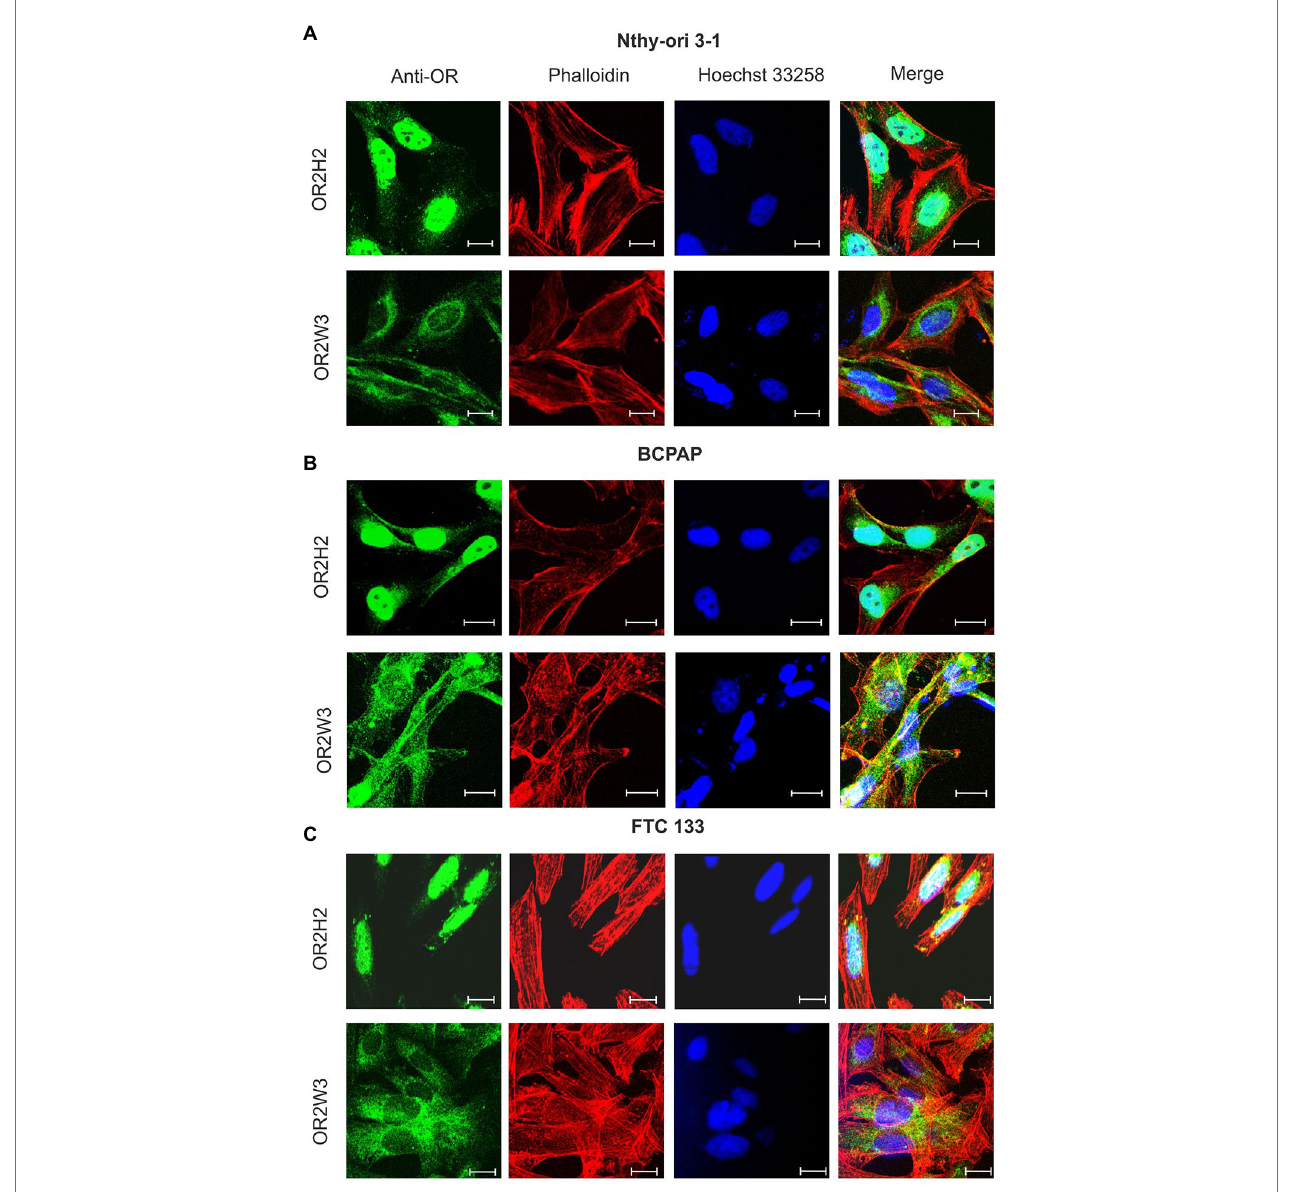
FIGURE 2 | Localization of OR2H2 and OR2W3 in human thyroid cell lines. Nthy-ori 3-1 (A) , BCPAP (B) , and FTC 133 (C) cells were stained with specific antibodies against OR2H2 and OR2W3 (green), the cytoskeleton (red) was marked with phalloidin, whereas the cell nucleus (blue) was stained with Hoechst 33258. The scale bar corresponds to 20 μ